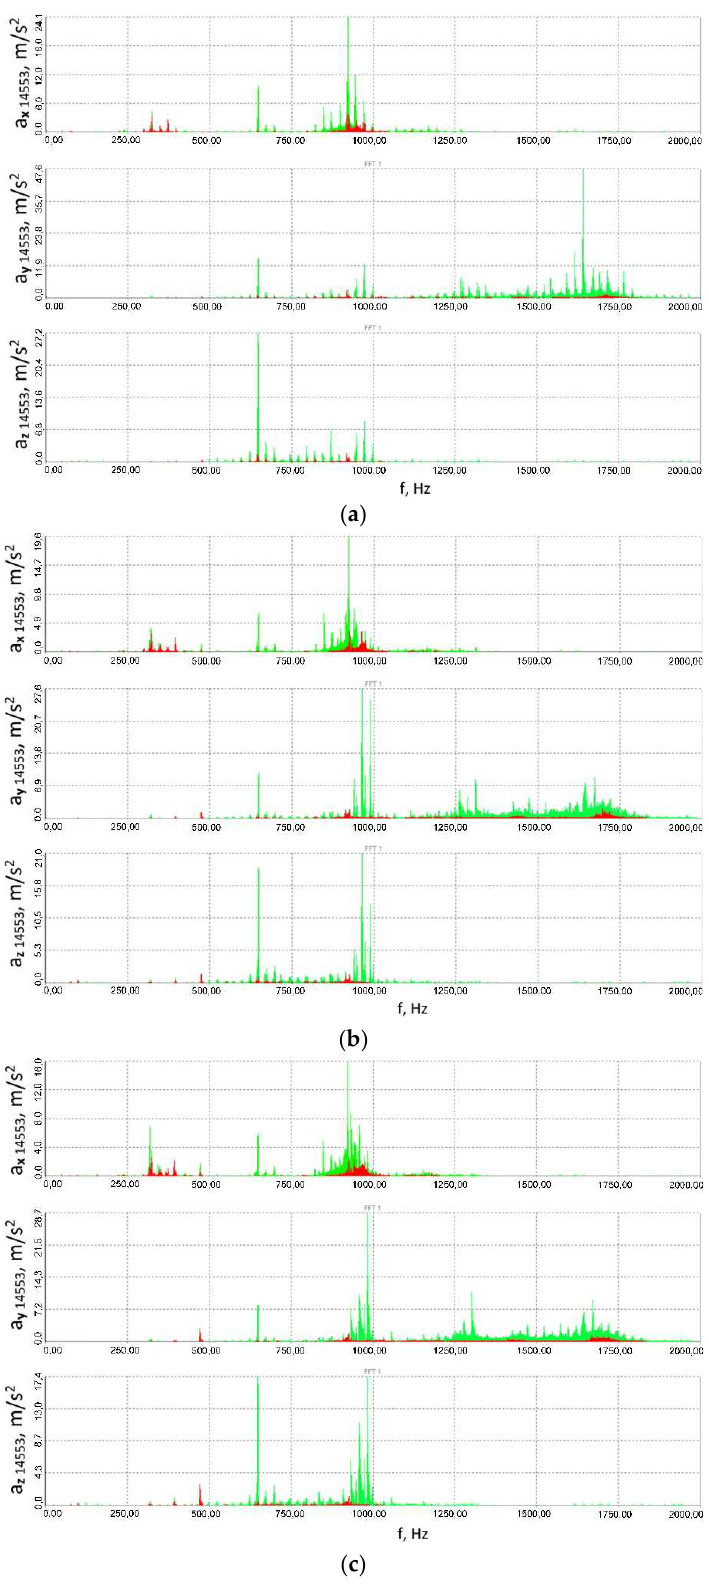
Figure 17. Spectra (FFT) of the vibration acceleration signals measured at the input shaft housing in the multi-stage reduction gear (point 14553): ( a ) 41.8 ± 27.9 Nm, ( b ) 79.2 ± 55 Nm, ( c ) 114.8 ± 75.9 Nm; red colour corresponds to the flexible clutch operation mode, green—locked clutch operation